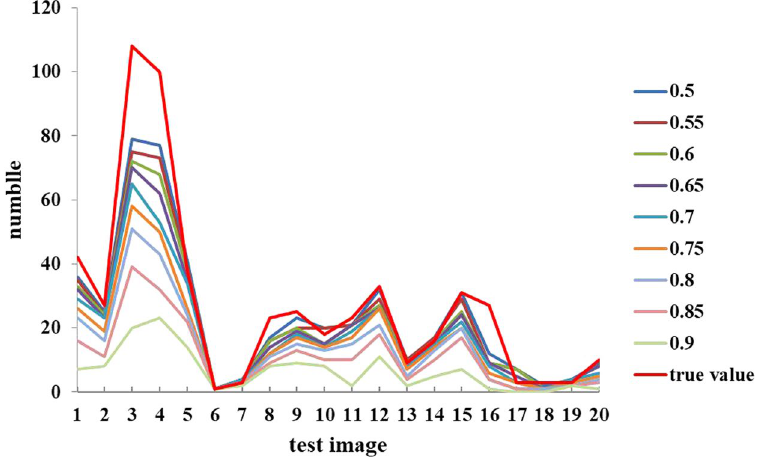
Figure 9. Comparison of the counting results under different score thresholds, sth. All the images for this experiment are from the Dataset B sampled with 1440 × 1080 pixels.